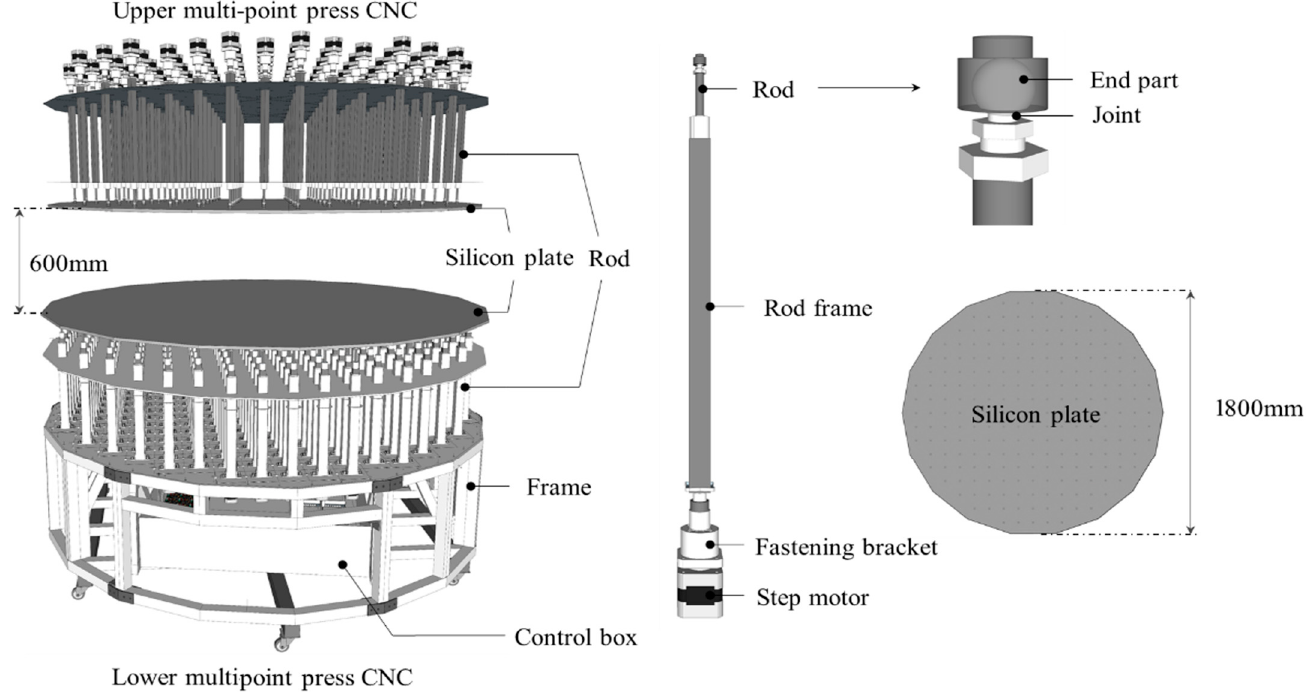
Figure 5. Composition of double-sided multipoint press equipment.